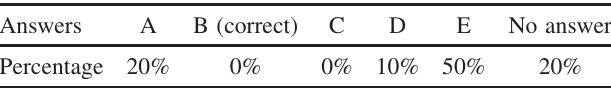
TABLE I. The choice distribution of 10 students answering the question about stationary state and eigenstate after traditional